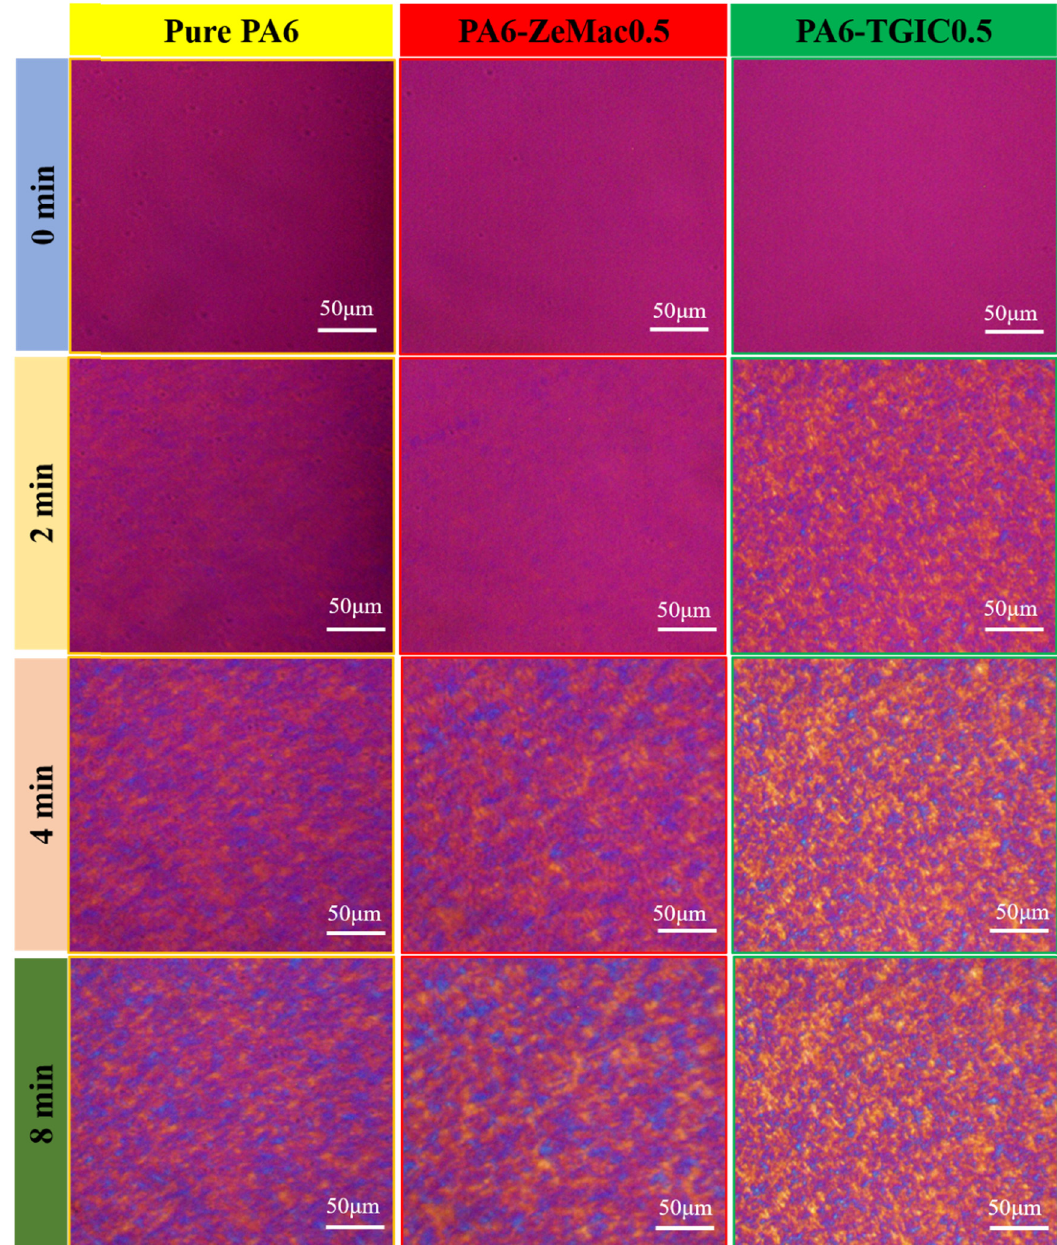
Figure A1: POM images of pure PA6, PA6 - ZeMac 0.5, and PA6 - TGIC 0.5 isothermally crystallized at